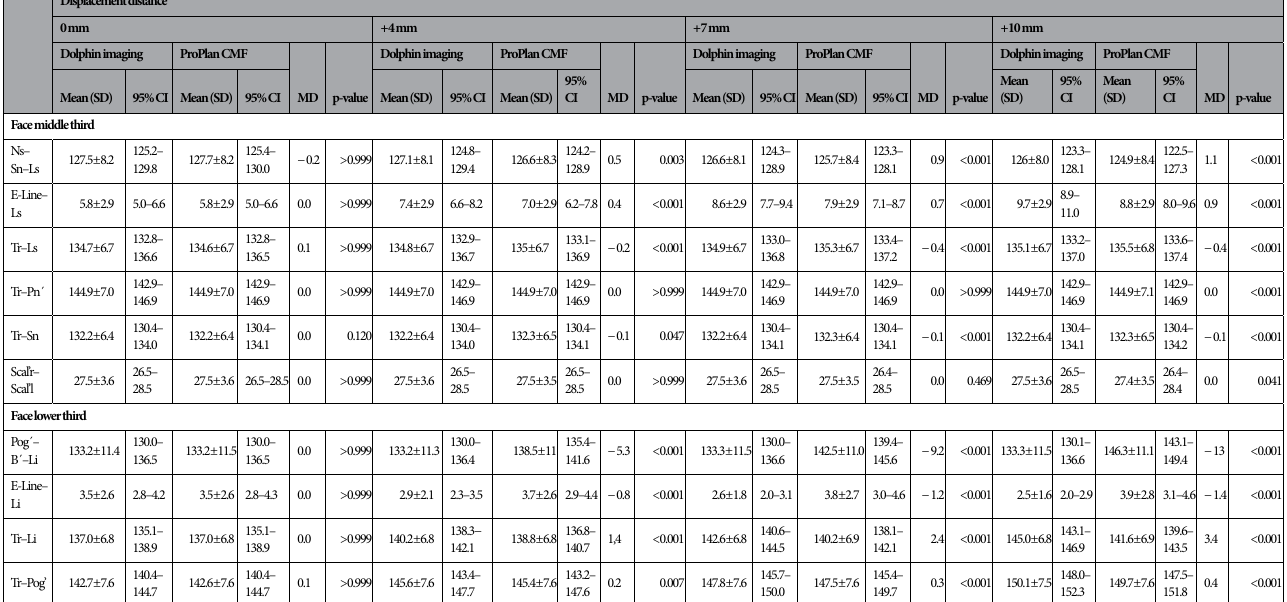
Table 6. Mean values, SDs and 95% confidence intervals of the angular and linear changes in the middle and lower third of the face after mandibular surgery simulation with the corresponding p values of the comparison between the outcome of the surgical planning program Dolphin and ProPlan depending on the different displacement distances for mandibular advancement. SD standard deviation, CI confidence interval, MD mean difference.